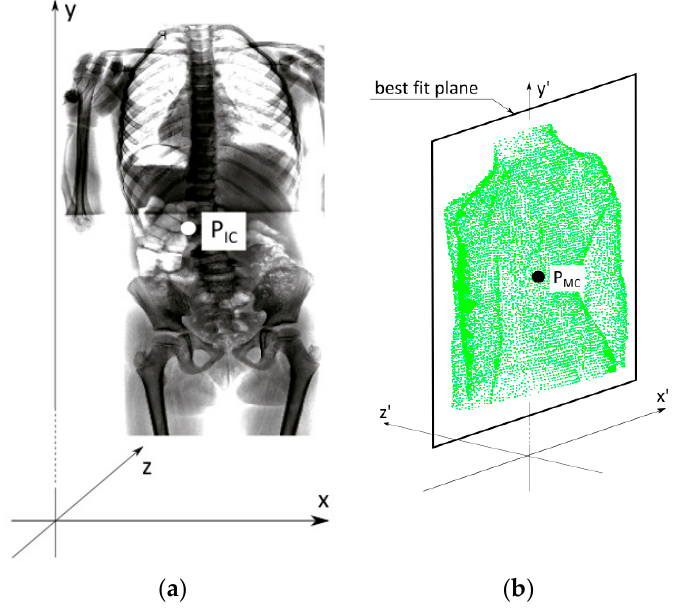
Figure 3. Coordinate systems of an X-ray image and the cloud of points before alignment. ( a ) The radiogram is incorporated into the xyz coordinate system. P IC —the central point of the image. ( b ) The three-dimensional surface topography (3D ST) image from the structured light imaging system. P MC —the point of the center of gravity of the cloud of